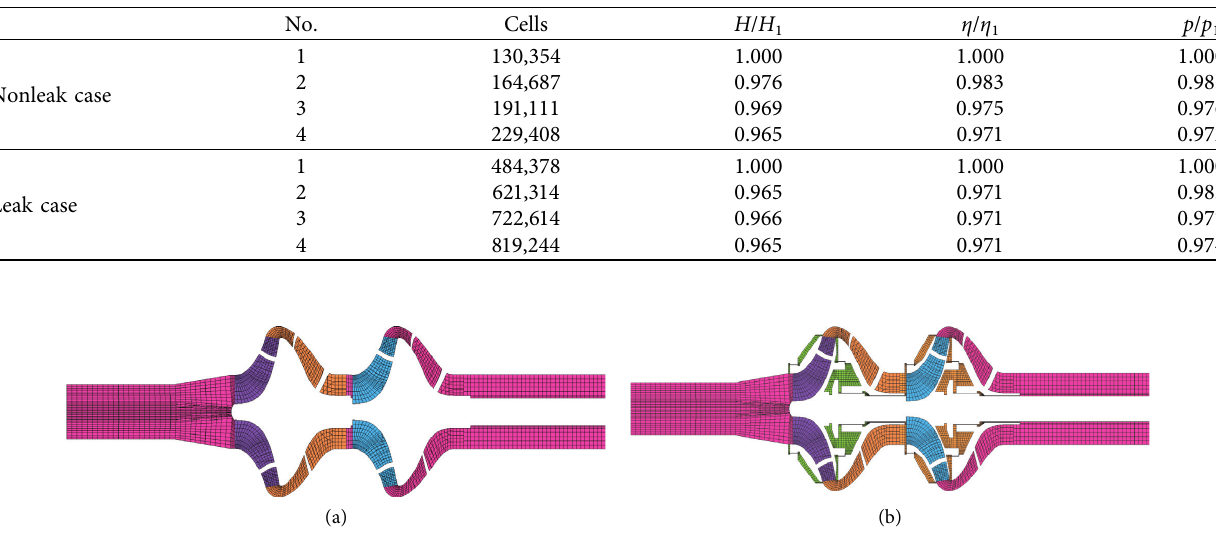
Figure 4: Computational grids of slurry transport pump: (a) non-leak case and (b) leak